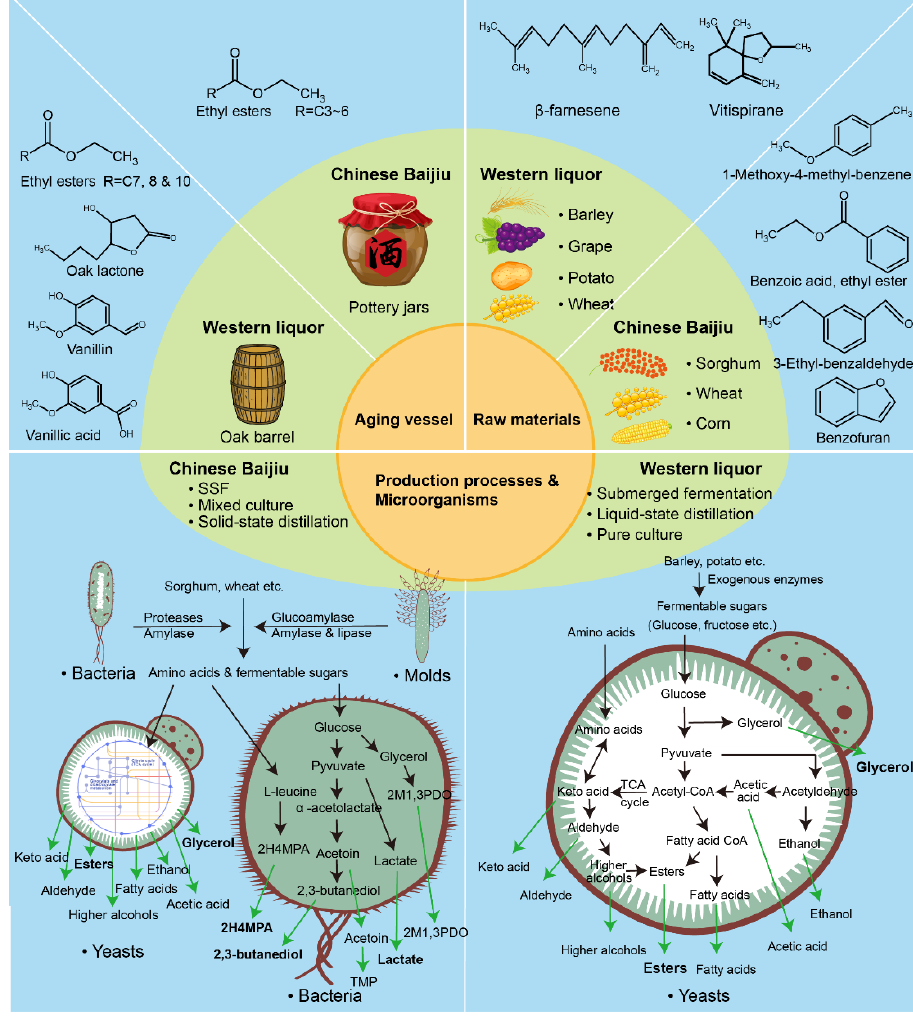
Figure 5. Factors that contribute to the compositional difference between Chinese baijius and Western liquors, and representative compounds associated with each factor. In the orange core circle are the major contributing factors: raw materials, production processes, microorganisms, and aging vessel. In the middle green ring are the corresponding elements of the factors. The blue periphery ring are key compounds influenced by the core factors. The model of the production processes and microorganisms briefly describes the biochemical production pathways of a few major compounds. C7, 8 and10 represents R contains C7, C8, and C10 linear chain length, respectively; C2–C6 represent R containing C2–C6 linear chain length, respectively. SSF: simultaneous saccharification and fermentation; 2H4MPA: 2-hydroxy-4-methyl-pentanoic acid; 2M1, 3PDO: 2-methyl-1,3-propanediol;